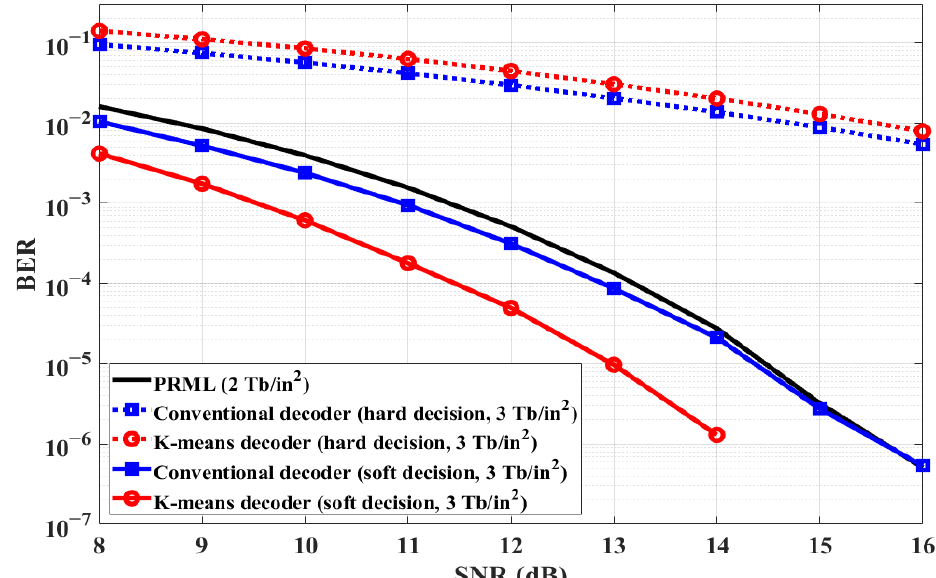
Figure 3. BER performance of the decoding schemes according to SNR.